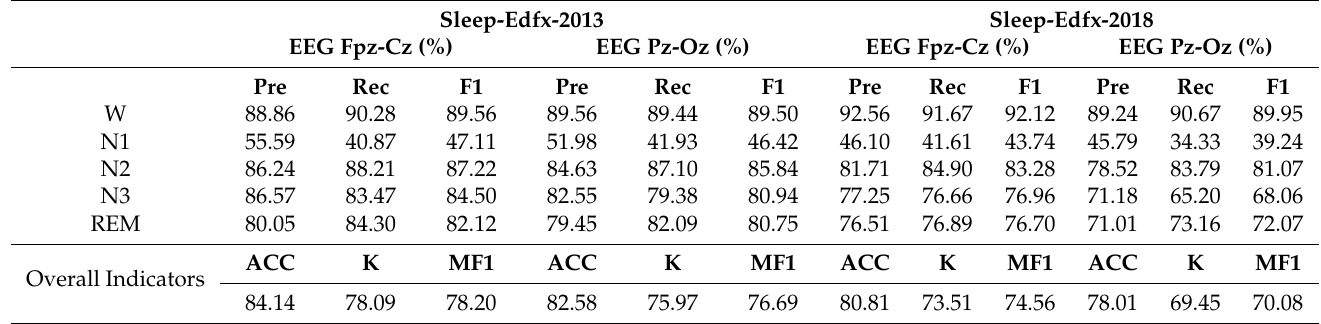
Table 3. Evaluation indicators for the overall and each category are obtained from two